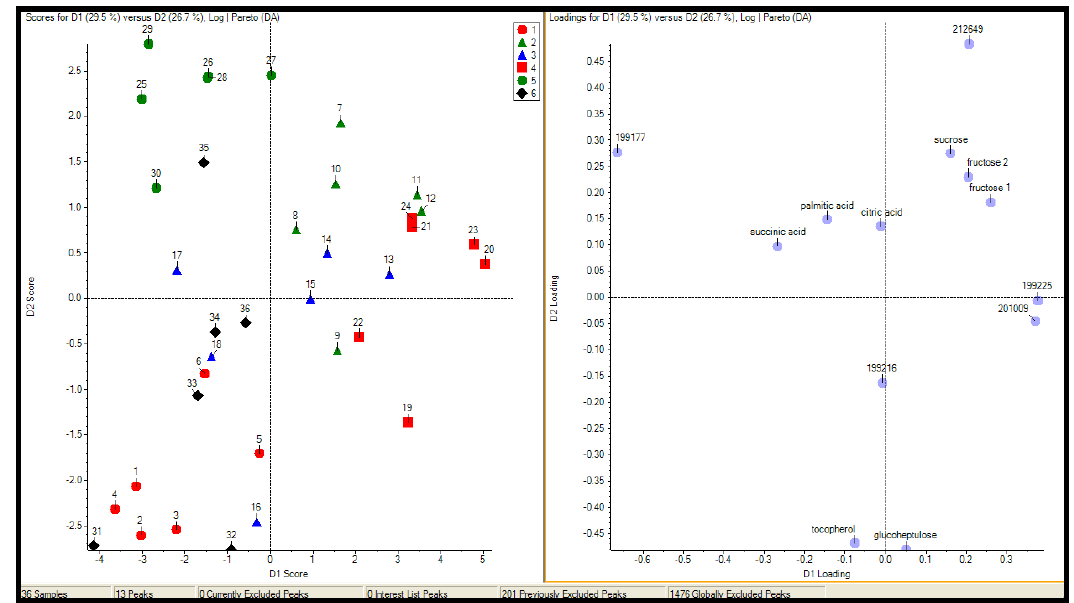
Figure 3c. PCA-DA score and loading plots generated with top 10 predictors derived by GA